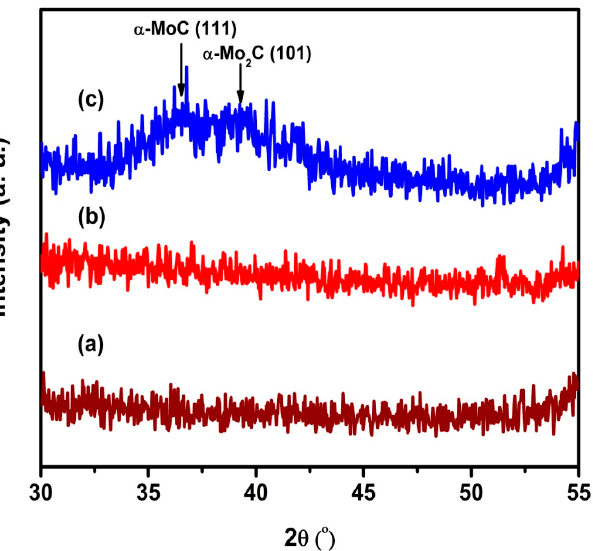
Figure 6. XRD patterns of Mo-DLC coatings on Si substrate: ( a ) Si substrate, ( b ) 3.9 at.% Mo, and ( c ) 16.2 at.% Mo.